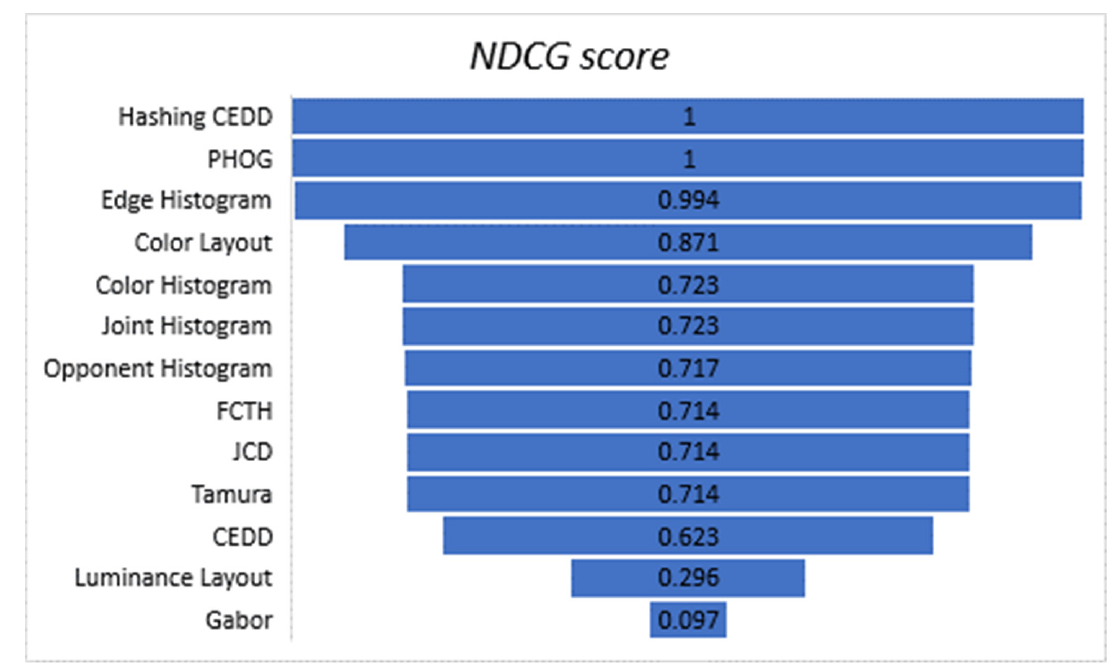
35 of 38 Figure 23. Precision@10000 retrieval quality. Here, the rank is classified into four categories (2, 1, 0, –1) according to the relativity